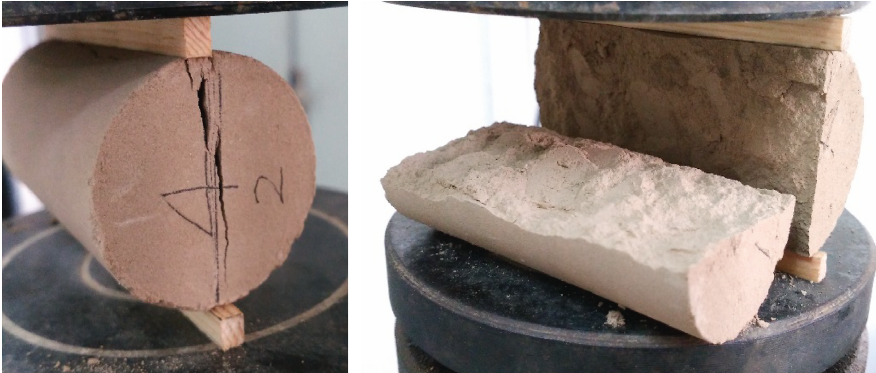
Figure 3: Indirect tension